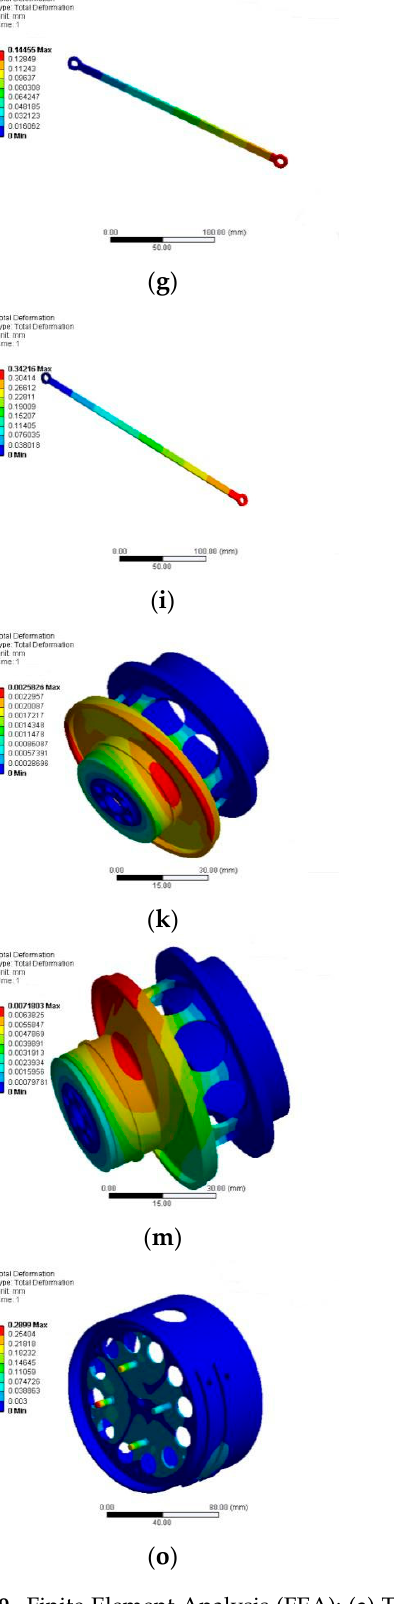
Figure 9. Finite Element Analysis (FEA): ( a ) The total deformation of the thigh; ( b ) the equivalent stress of the thigh; ( c ) the total deformation of the calf; ( d ) the equivalent stress of the calf; ( e ) the total deformation of the foot; ( f ) the equivalent stress of the foot; ( g ) the total deformation of the linkage connecting the knee motor and knee joint; ( h ) the equivalent stress of the linkage connecting the knee motor and knee joint; ( i ) the total deformation of the linkage connecting the thigh and foot; ( j ) the